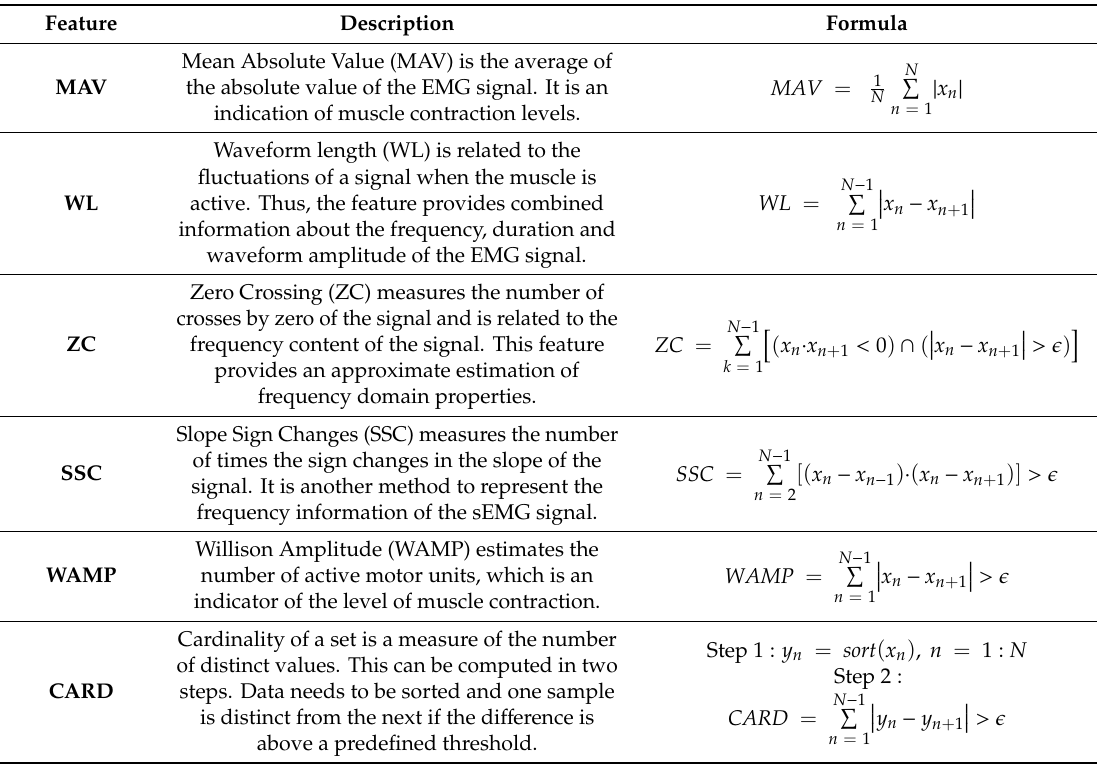
Table 2. Description of all features used in this study. N represents the total number of samples in a signal window, n is the sample index and ε is the threshold